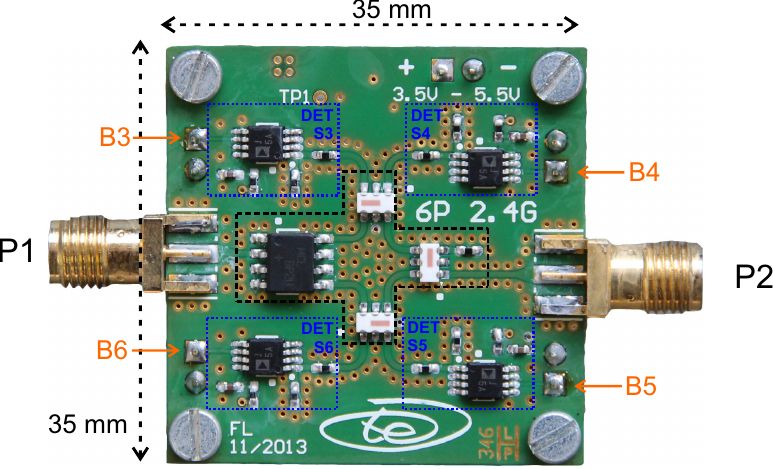
Figure 16. Photo of the 2.4-GHz six-port